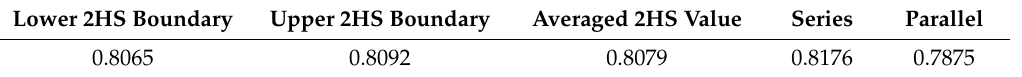
Table 7. Two-phase thermal conductivity approximations—cement system A. HS: Hashin–Shtrikman.